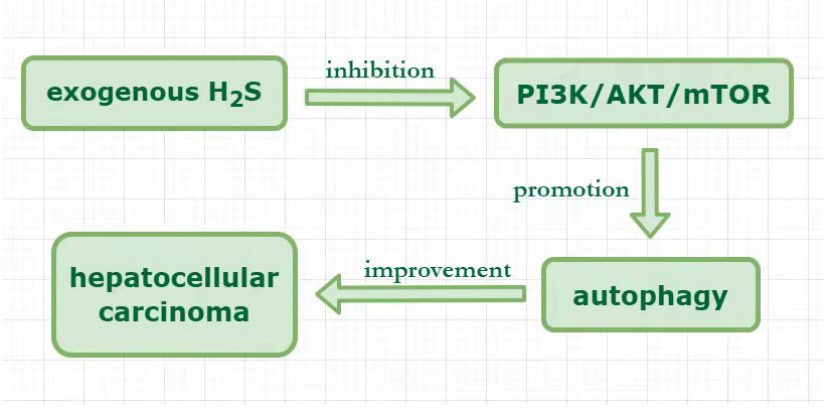
Figure 3. Hydrogen sulfide plays a protective role by regulating autophagy in hepatocellular carci-